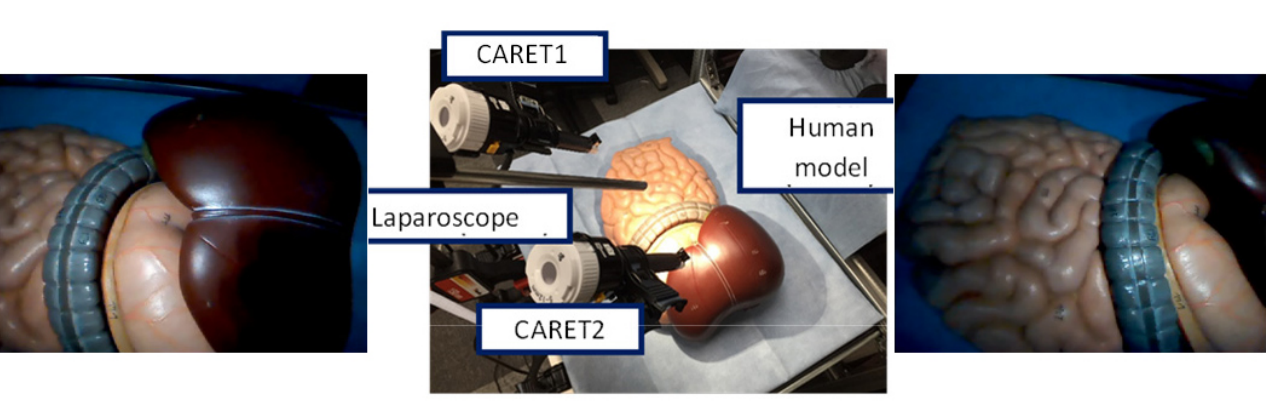
Figure 14. Human model experiment setup: human model environment with two CARET devices and a laparoscope as a light source in the middle; CARET-1 image on the left side and CARET-2 image on the right side.